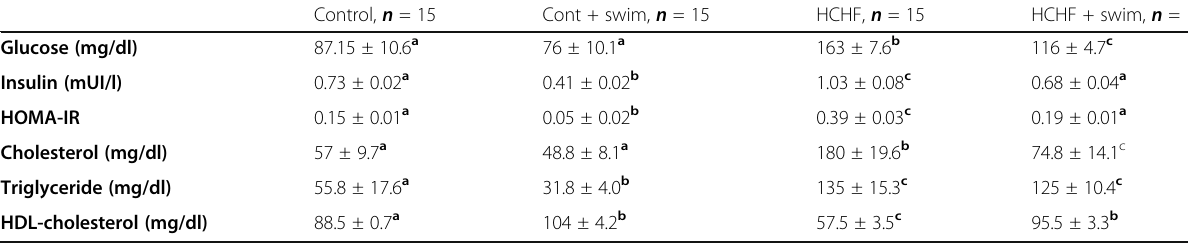
Table 2 Fasting glucose, insulin, HOMA-IR, and lipids profile in different groups